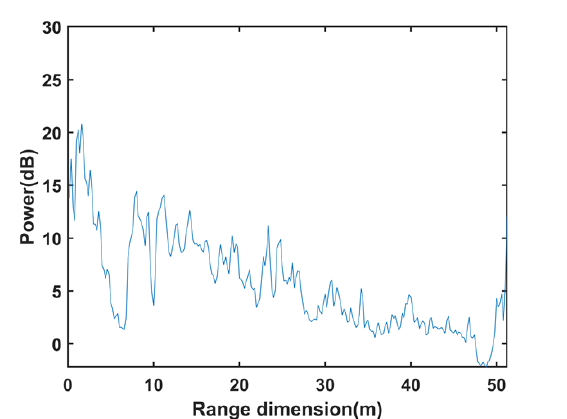
Figure 8. Background noise amplitude dispersion in RDM zero-Doppler